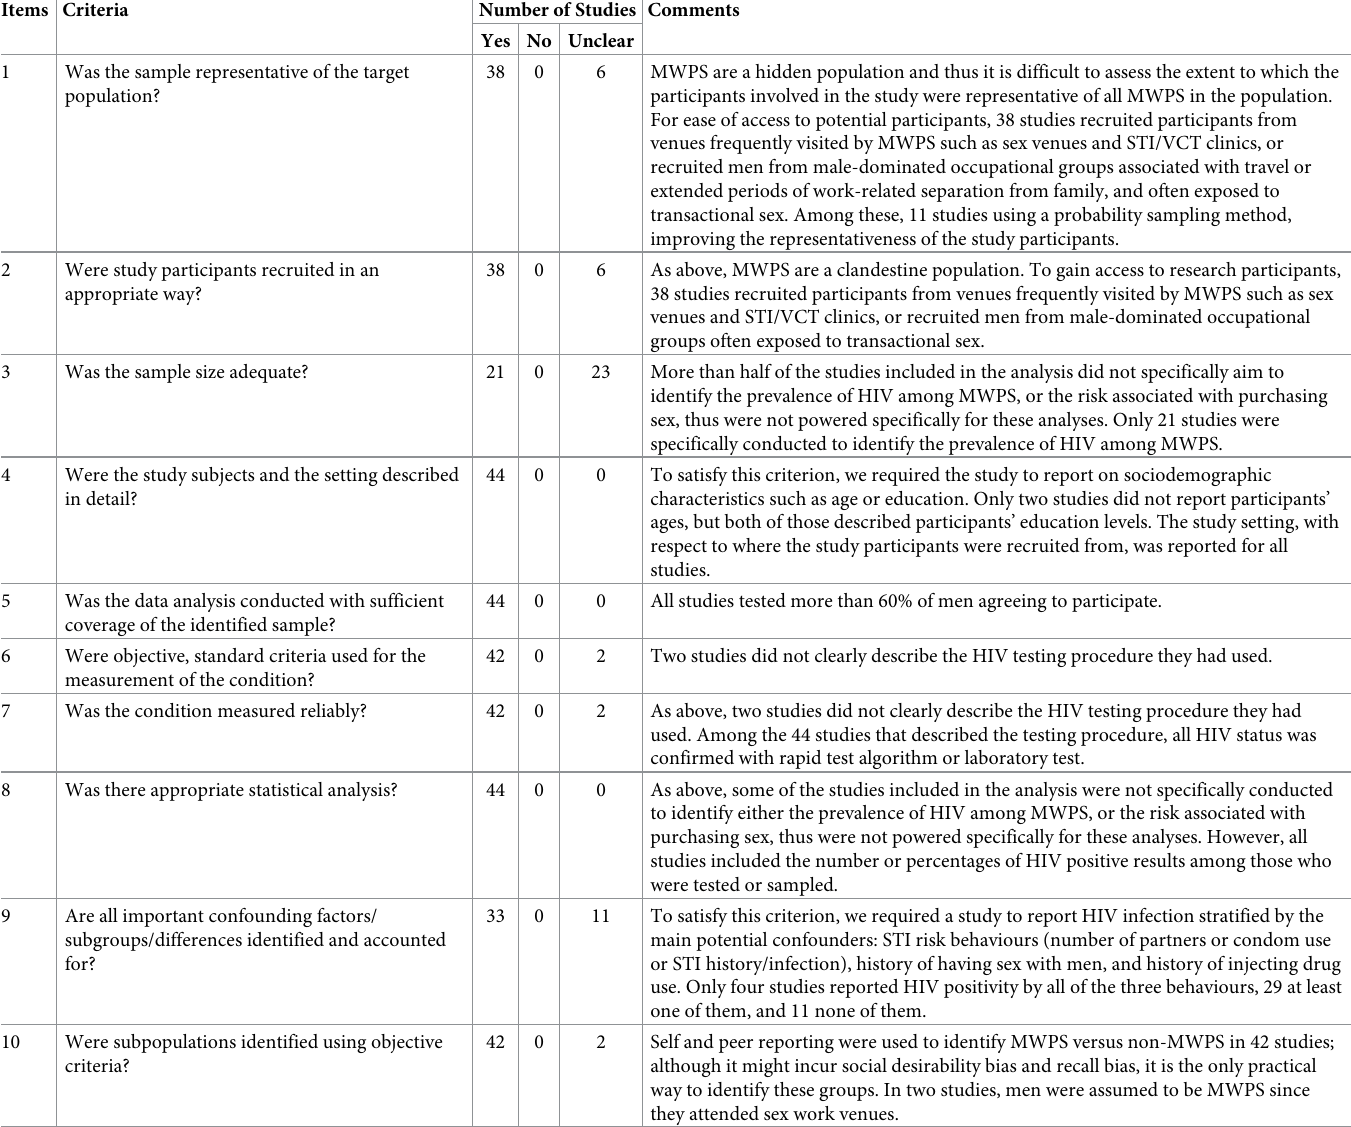
Table 4. Assessment of study quality using Joanna Briggs Institute critical appraisal